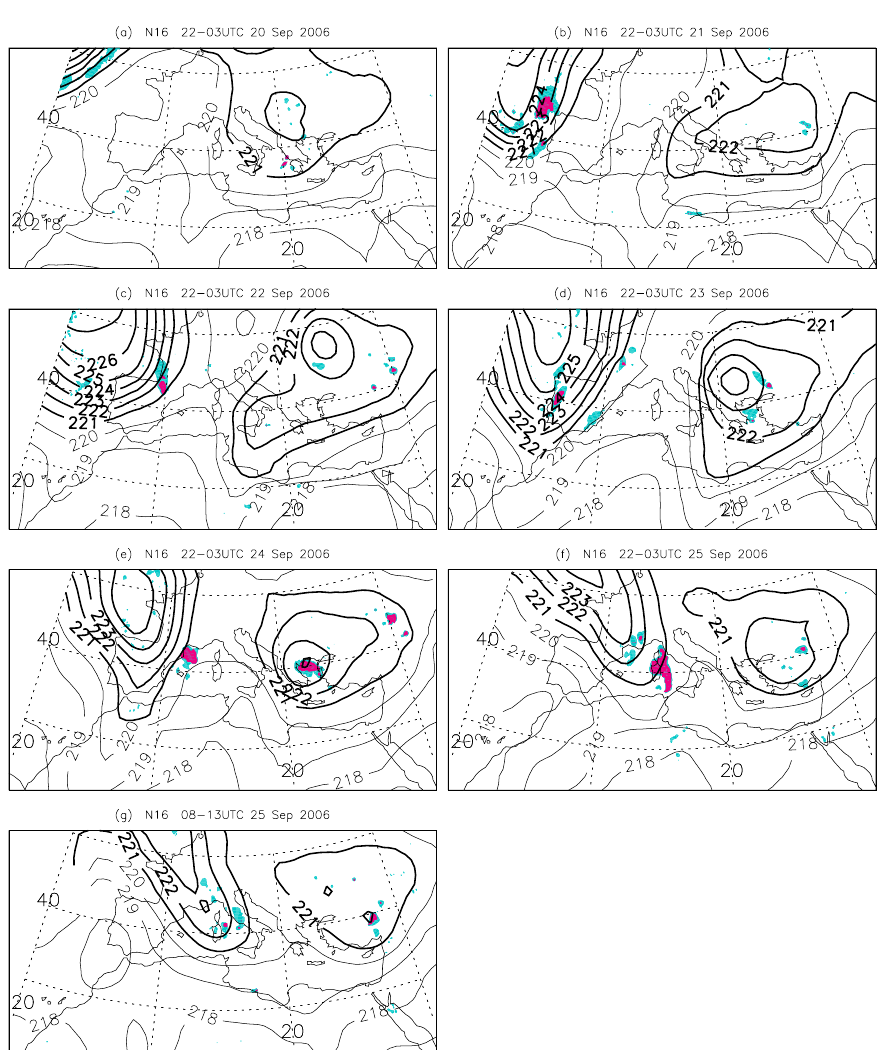
Fig. 4. AMSU-A channel 8 (solid, thick dark for A-8 BT larger or equal to 221K), B3m5 (larger or equal to − 8K, blue shaded), and DCT Figure 4 (red shaded) for (a–f) , descending (22:00–03:00UTC) and (g) , ascending (08:00–13:00UTC), NOAA-16 passes, 20–25 September 2006.